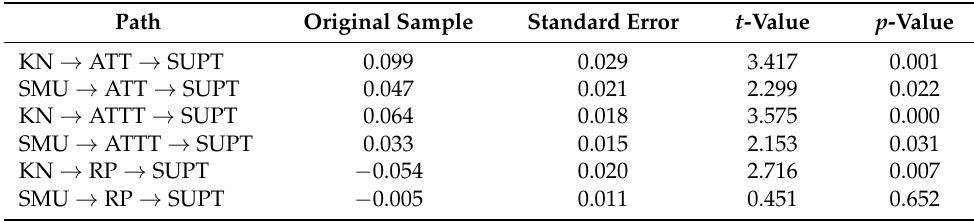
Table 6. Results of mediation